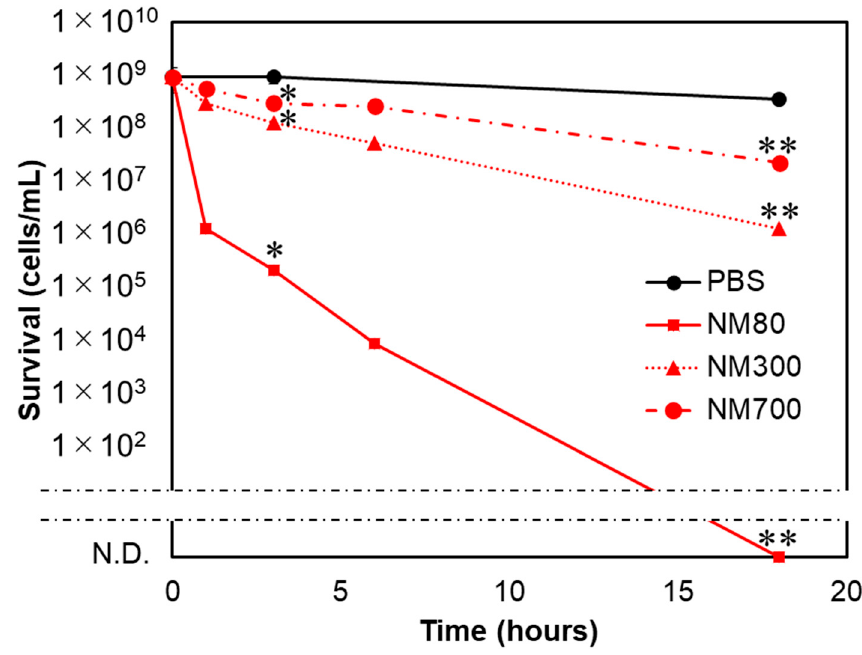
Figure 3. Size-dependent bactericidal effects of magnesium hydroxide nanoparticles. Different sizes of the magnesium hydroxide nanoparticles (NM80, NM300, and NM700) were compared for their bactericidal effects against E. coli . The concentration of each nanoparticle used was 500 mg/L. The characteristics of each nanoparticle are indicated in Figure 1 and Table 2. The black line indicates the PBS treatment as a control. N.D. means “not detected.” Student’s t -tests were used to compare bactericidal effects of each sample relative to that of PBS (* indicates a p -value < 0.05 and ** indicates a p -value < 0.01).